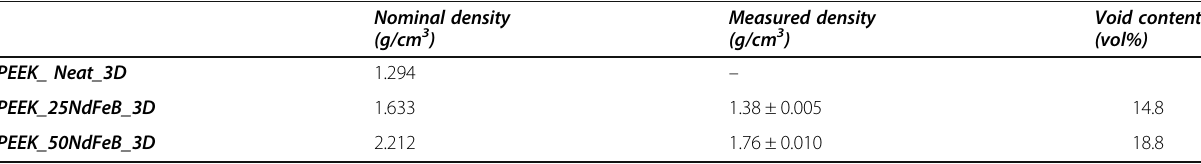
Table 11 Expected values after apparent density measurement of the printed parts